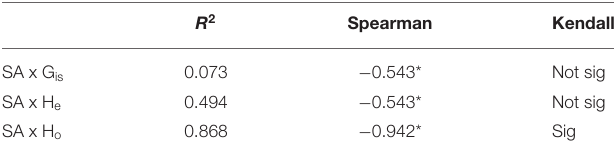
surface abundance ( R 2 = 0.073, rs = − 0.543, τ not statistically significant; Table 3